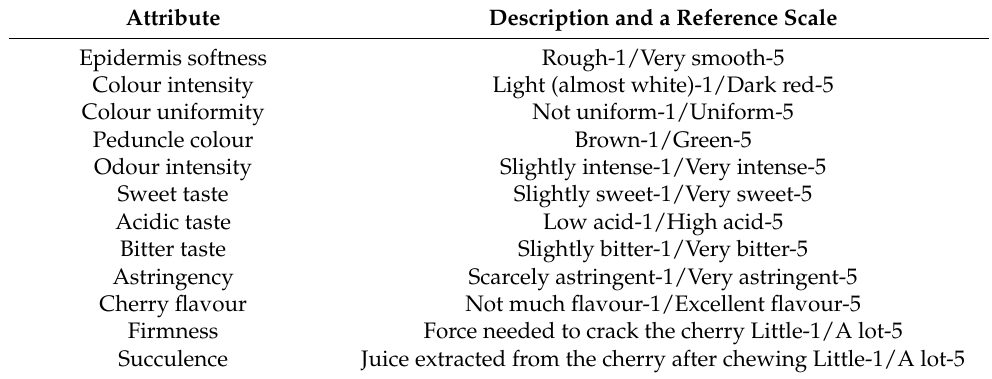
Table 1. Vocabulary adapted from Chauvin et al. [46], and reference standards used for descriptive sensory analysis of cherries.